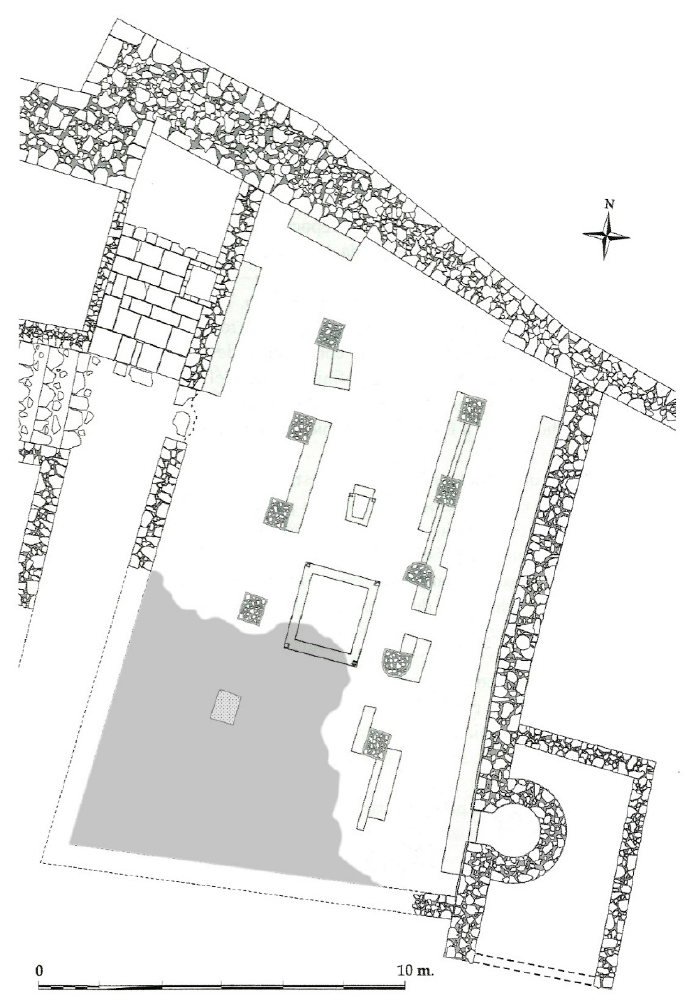
Figure 5. Ground plan of the Synagogue of Molina de Aragón. Drawing by Fernando Lechuga, based on a plan of Jesús Arenas. Used by permission.